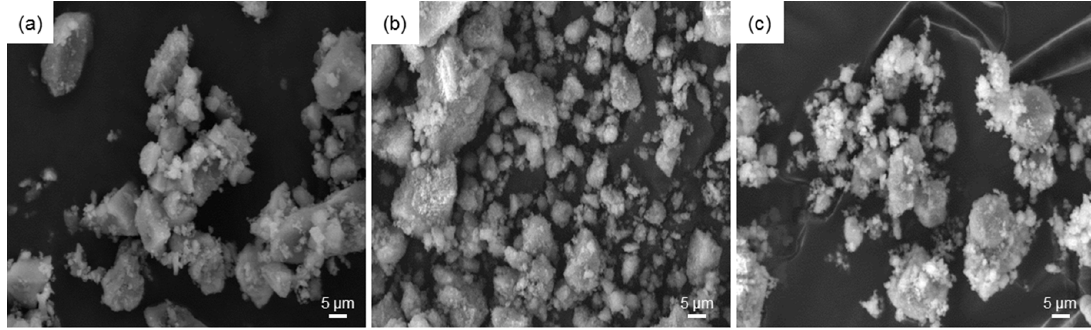
Figure 6. SEM micrographs of: ( a ) 60S40C-air; ( b ) 60S38C2Fe-air; and ( c ) 60S30C10Fe-air powders.